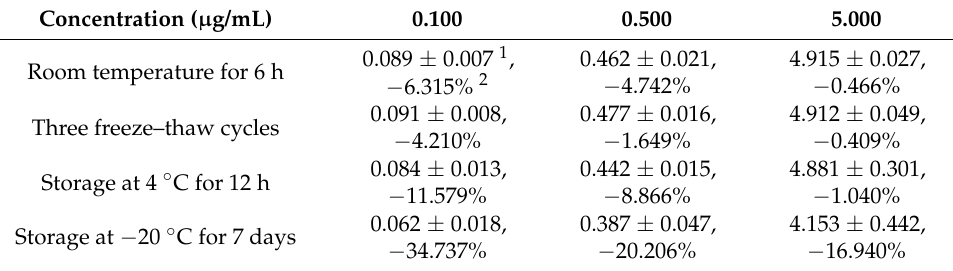
Table 2. Stability of AWRK6 QC samples.